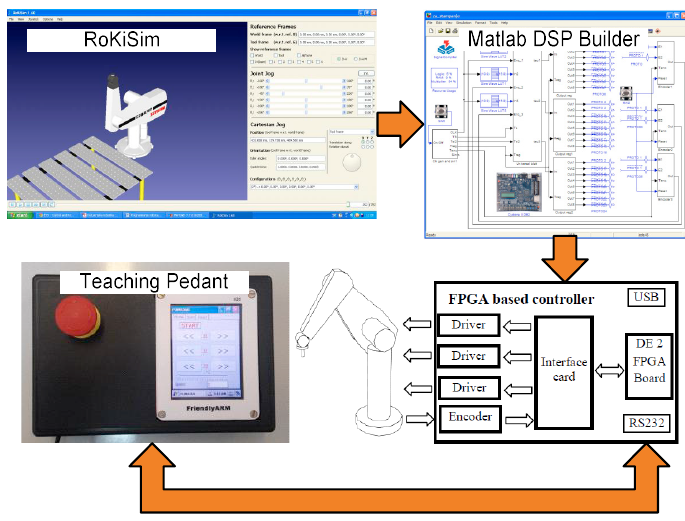
Figure 2. DRE block diagram for robot PUMA 560 programming and control.